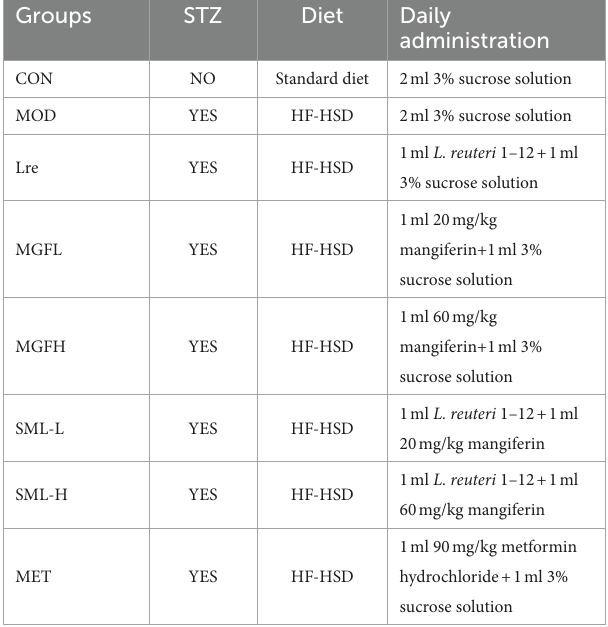
TABLE 1 Treatment methods of rats in each